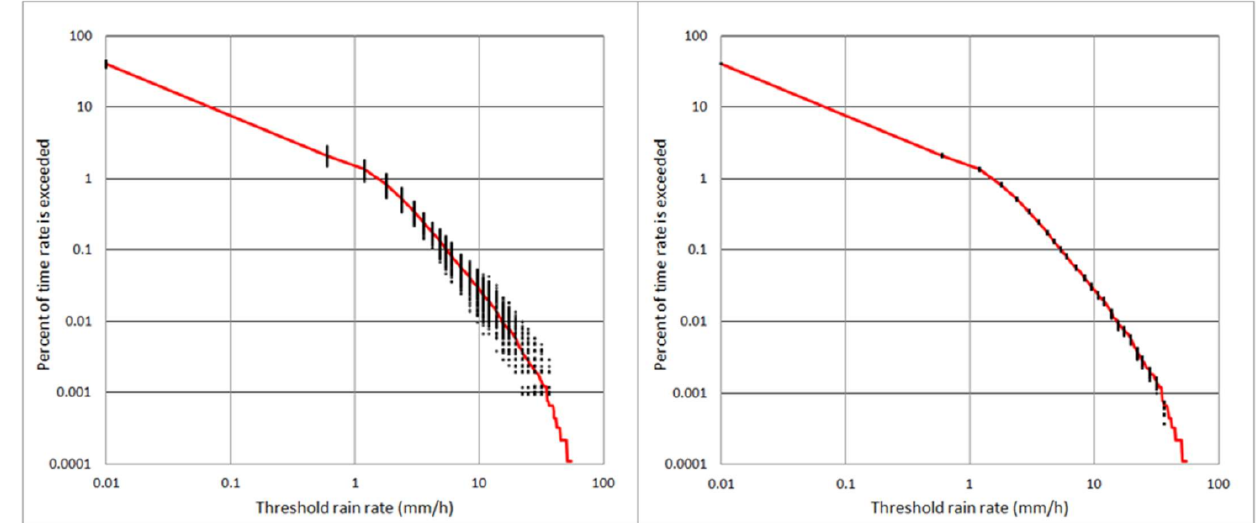
Figure 10. The average yearly variation of percentage of time of exceedance of rain rates (in mm h − 1 ) for wind speeds ≥ 7 m s − 1 for entire 18 years (red curve) and with black dots all possible samples of 2 years (left frame) and 16 years (right frame) for Hvide Sande 2002–2019.